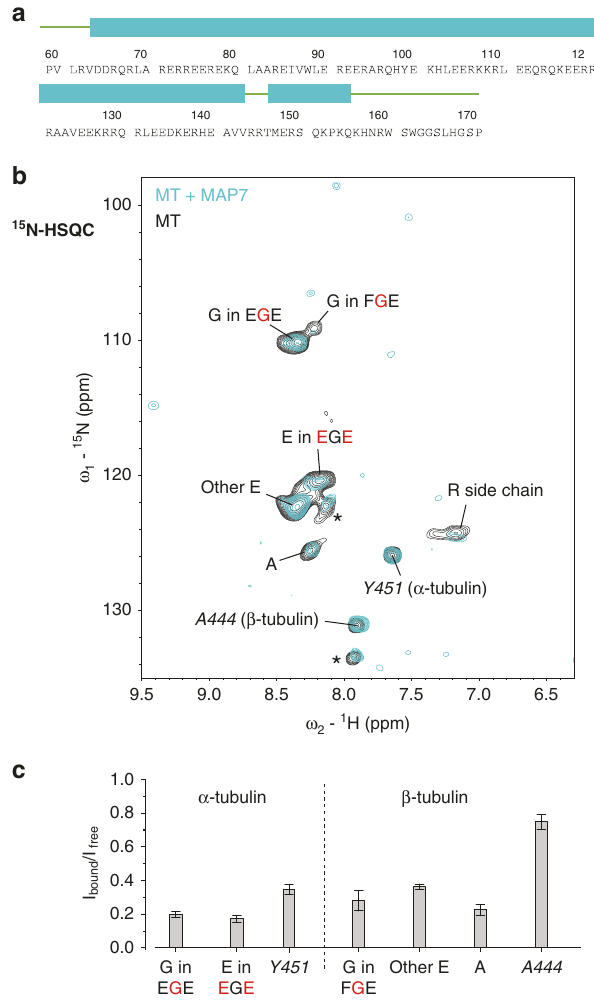
Fig. 5 Tubulin C-terminal tails interact with MAP7. a Secondary structure prediction of MAP7-MTBD by JPred 58 . b Spectral comparison of 2D 15 N- HSQC spectra obtained from [ 13 C, 15 N]-labeled MTs (black) and unlabeled MAP7-MTBD in complex with [ 13 C, 15 N]-labeled MTs (cyan). c Signal intensity ratios of resolved peaks in 15 N-HSQC between MAP7-MTBD bound MTs and free MTs. Error bars were calculated based on the NMR signal to noise ratio of each peak in the two spectra. Signal intensity ratios are provided as a Source Data fi